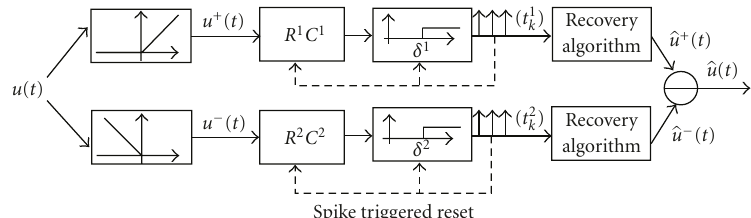
Figure 3: Circuit for encoding of stimuli velocity.